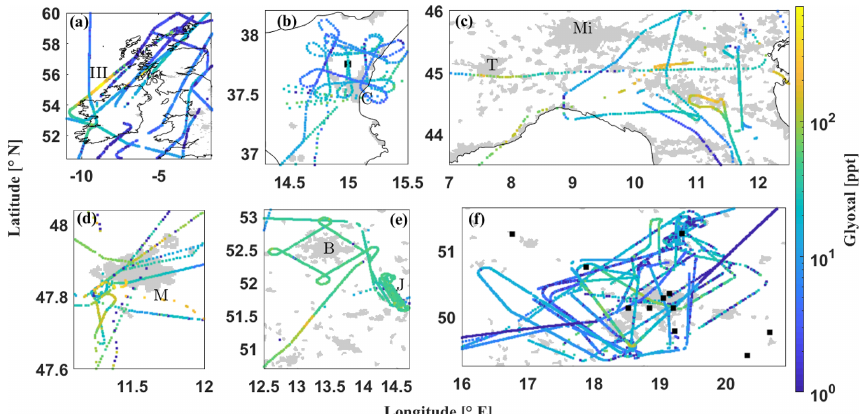
Figure 6. Examples of glyoxal measurements displayed over select regions of Europe, namely (a) over Ireland and Great Britain, with the crossing of plume III during a flight leg between the Irish north coast and Scotland, (b) eastern Sicily (Italy) around Catania (C), with Mount Etna (black square), (c) the Po Valley (Italy), with Turin (T) and Milan (Mi), (d) the Munich (M; Germany) metropolitan area, (e) the Berlin (B; Germany) metropolitan area, with the Jänschwalde power plant (J) in the southeast, and (f) the Upper Silesian Coal Basin (Poland), with the coal-fired power plants marked by black squares. Note the logarithmic scale of the colour axis. Grey areas mark population centres based on 2002–2003 MODIS satellite images (made with Natural Earth